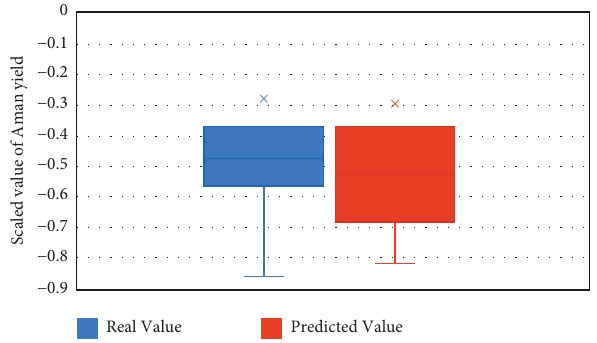
Figure 18: Comparison between real values and predicted values of Aman yield for SVR using box plot. Table 5: RMSE and r 2 value after Aman yield prediction.